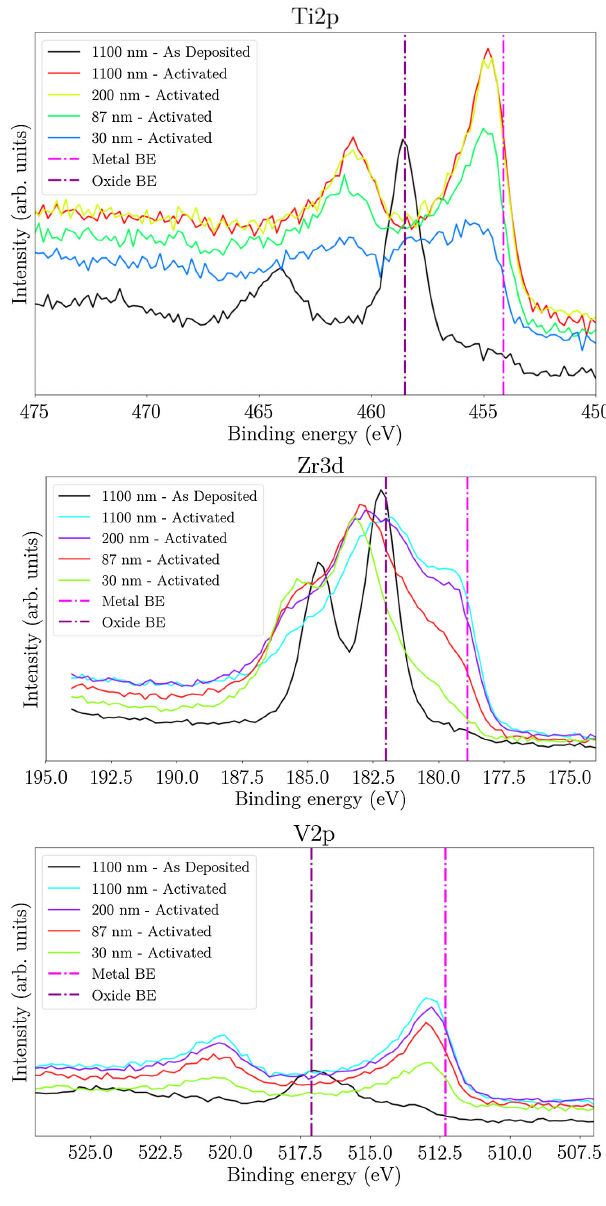
FIG. 9. Ti2p (top), Zr3d (center), and V2p (bottom) photopeaks obtained by XPS analysis for all the thicknesses under study. 2p and 3d refer to subshells of electronic